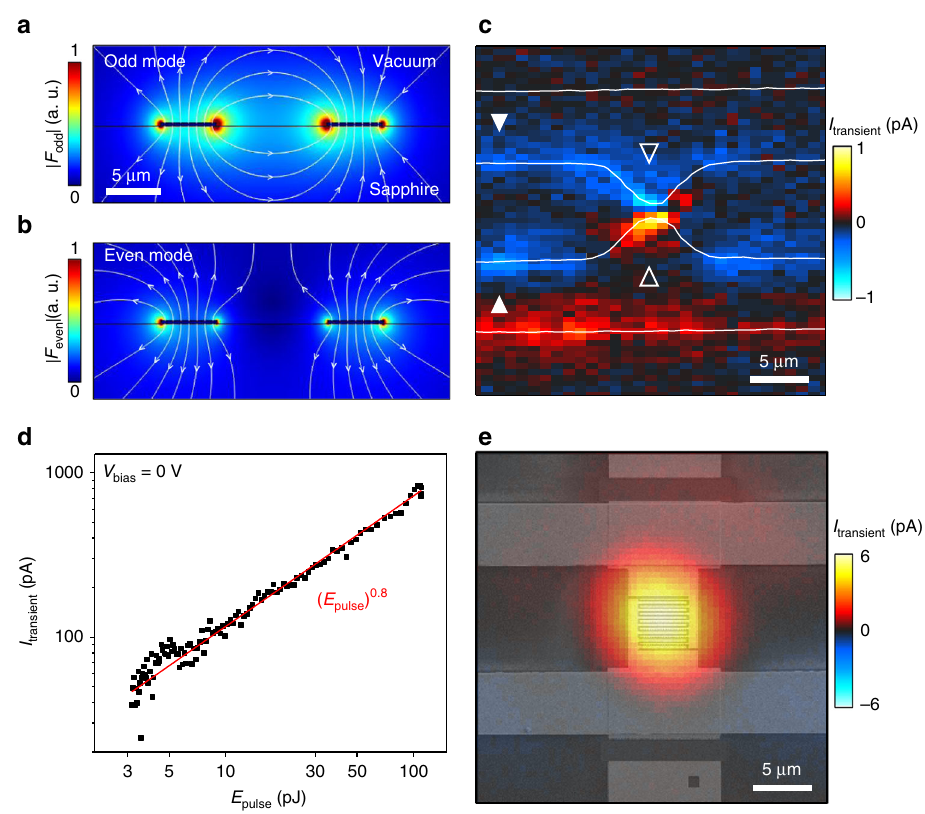
Fig. 4 Femtosecond near- fi eld coupling of NIR pulses to THz stripline modes. Simulated electric fi eld distribution of the co-planar striplines (black) with a the odd mode and b the even mode. Color code describes the absolute electric fi eld. The arrows denote the direction of the electric fi eld vector in the image plane. c Spatial map of I transient at fi xed Δ t for a sample without nanojunctions (white lines indicate the striplines). The odd mode is excited in the center with a minimum distance of 1 µ m between the striplines (open triangles). The even mode is excited at edges where the striplines have a distance of 10 µ m ( fi lled triangles). d I transient vs E pulse for striplines without nanojunctions showing an almost linear dependence (red line). e Spatial map of I transient